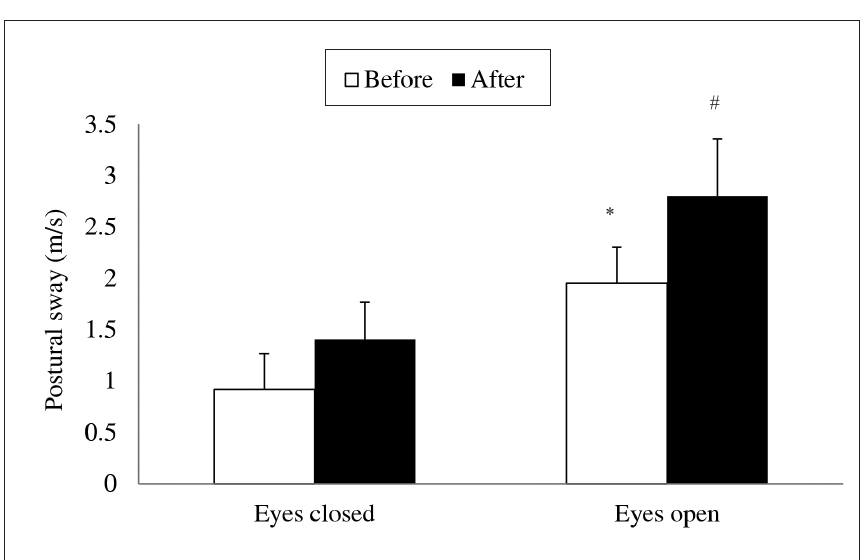
Figure 6. Boys’ body balance test results with eyes open and eyes closed before and after high- intensity